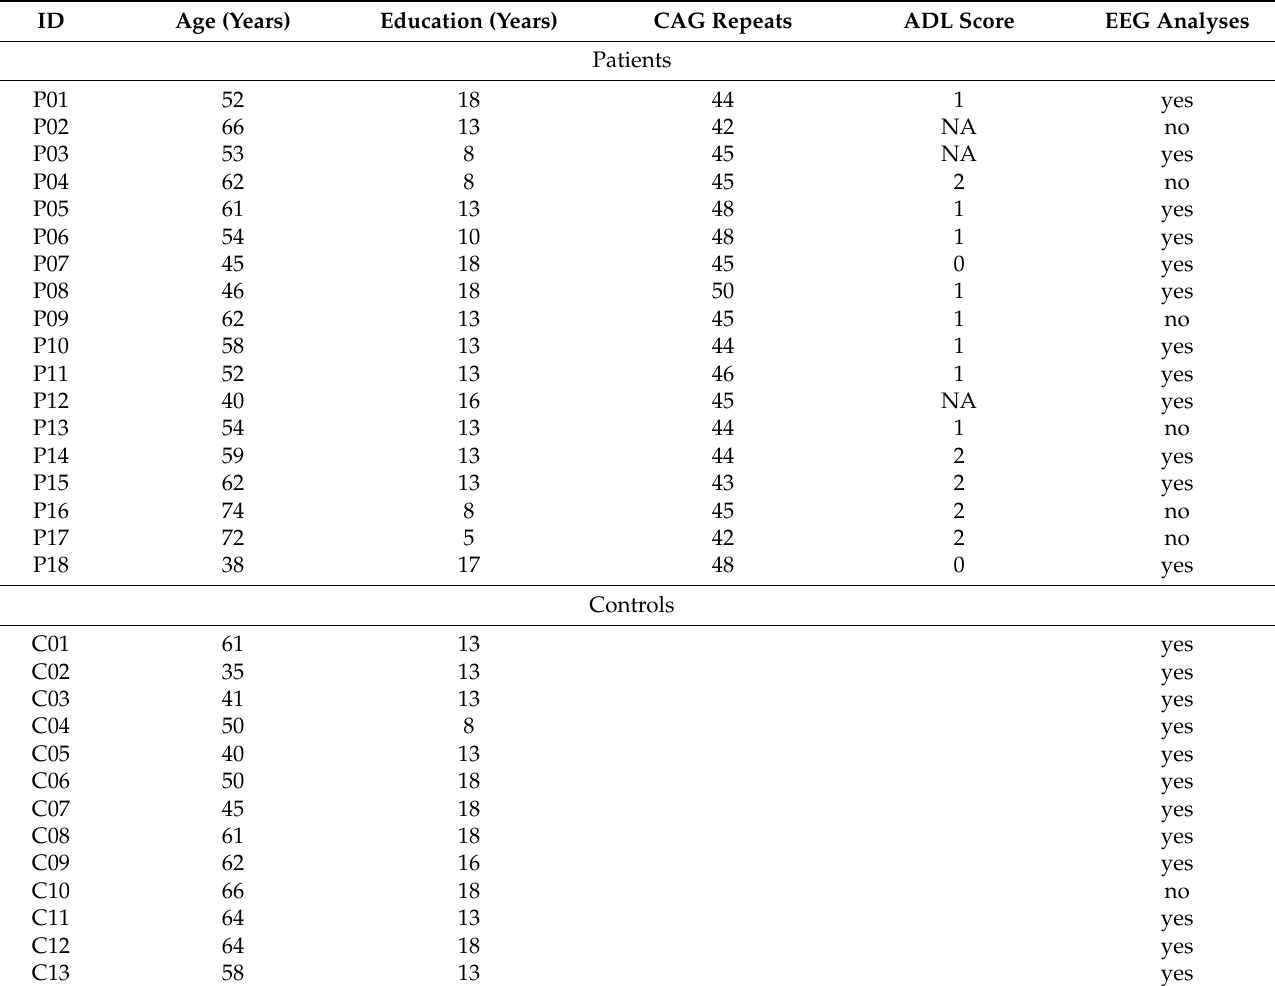
Table 1. Demographic characteristics of patients with SBMA and the control